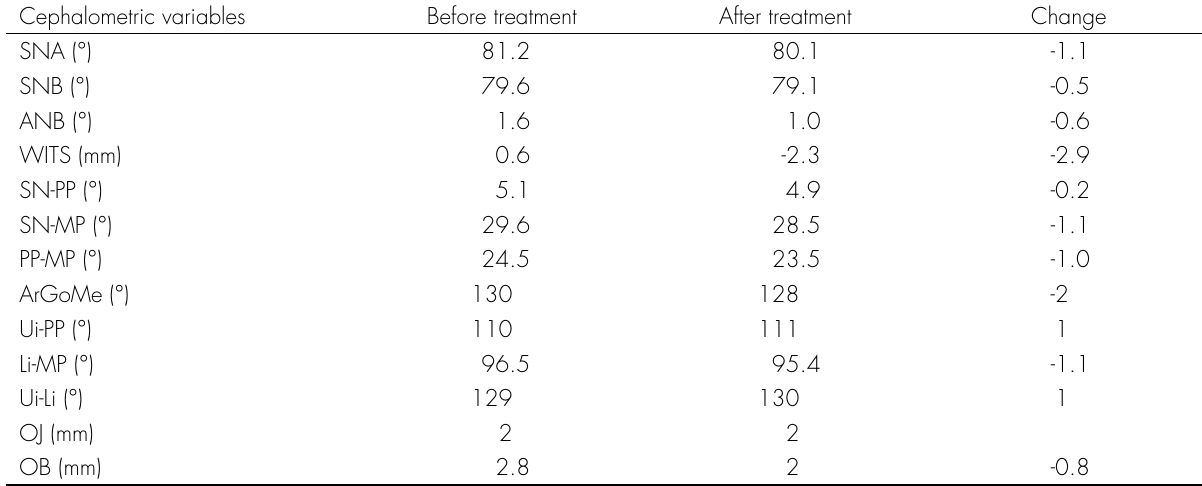
Table I. Changes in cephalometric variables before and after treatment.